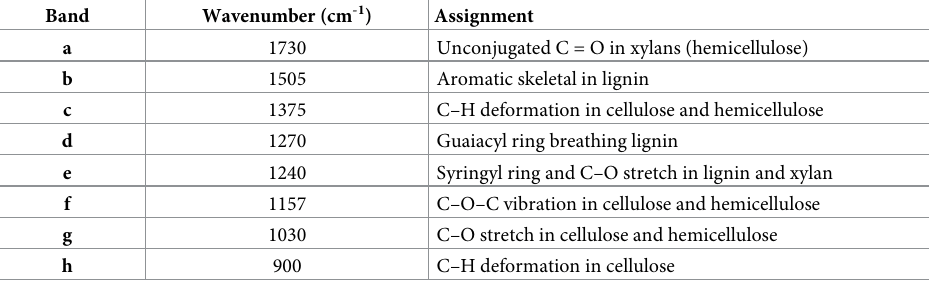
Table 2. Assignments of the FT-IR bands reported in Fig